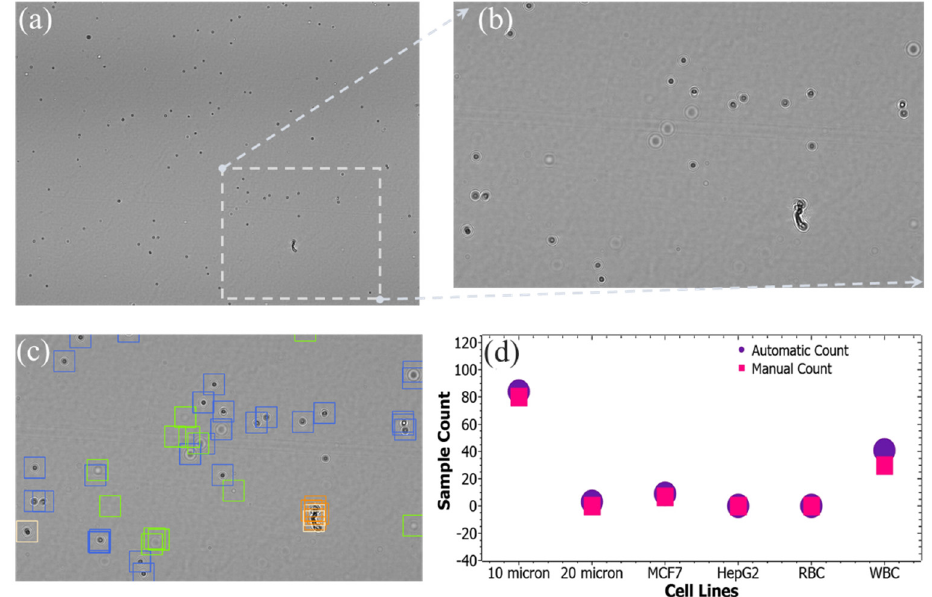
Figure 7. Comparison between the proposed AI method and the manual method for counting. ( a ) A whole frame LSIT micrograph, ( b ) magnified region-of-interest (ROI) of the whole frame LSIT micrograph, ( c ) automatically classified cell diffraction patterns of the ROI, and ( d ) comparison of the cell counts between those two different modalities.